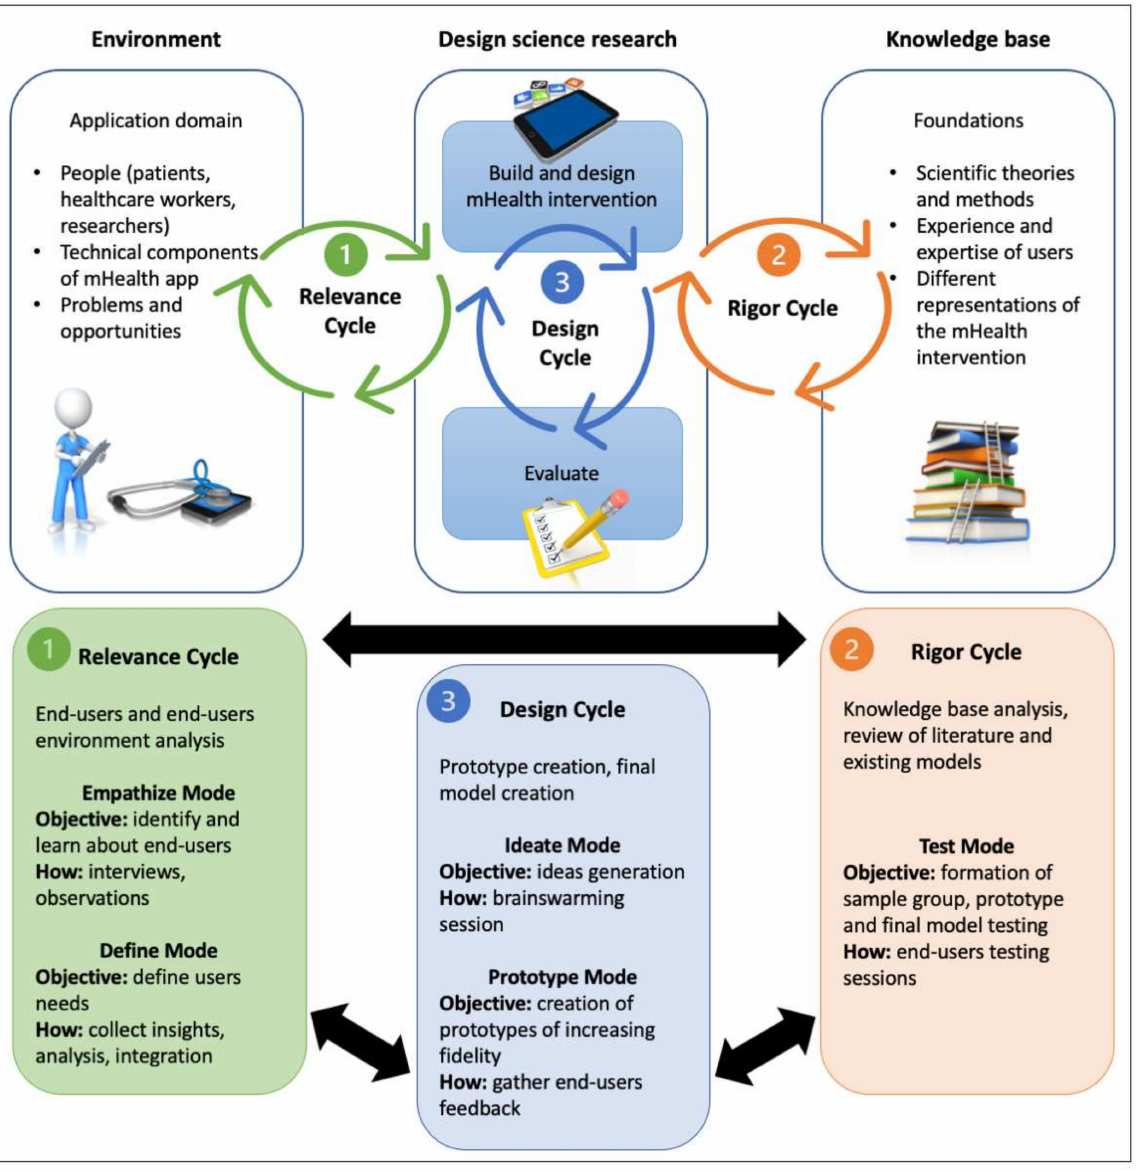
Figure 1. Modified Information Systems Research framework, incorporating modes of design thinking into the relevance, design, and rigor cycles. Adapted from Farao J. et al. “A user-centered Design framework for mHealth”, 2020 [10] (Creative Commons Attribution